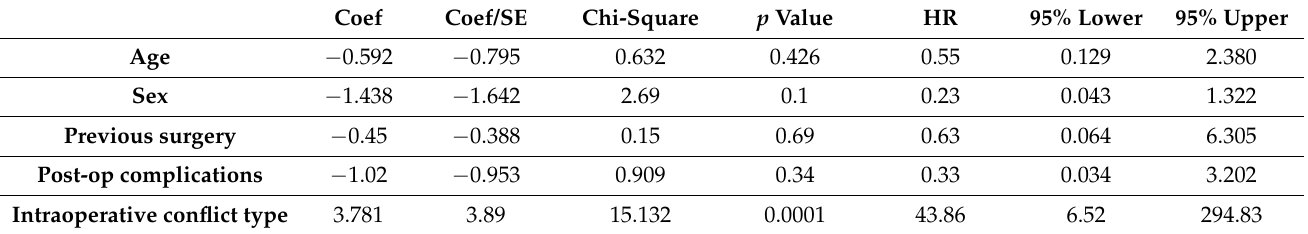
Table 4. Multivariate analysis for pain-free